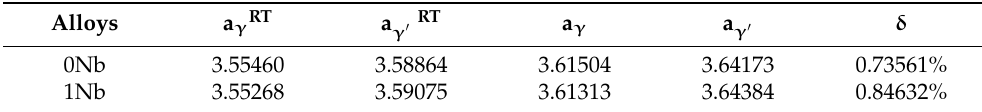
Table 3. The calculated lattice parameters (Å) at ambient and 800 ◦ C, and misfit δ at 800 ◦ C of the 0Nb and 1Nb